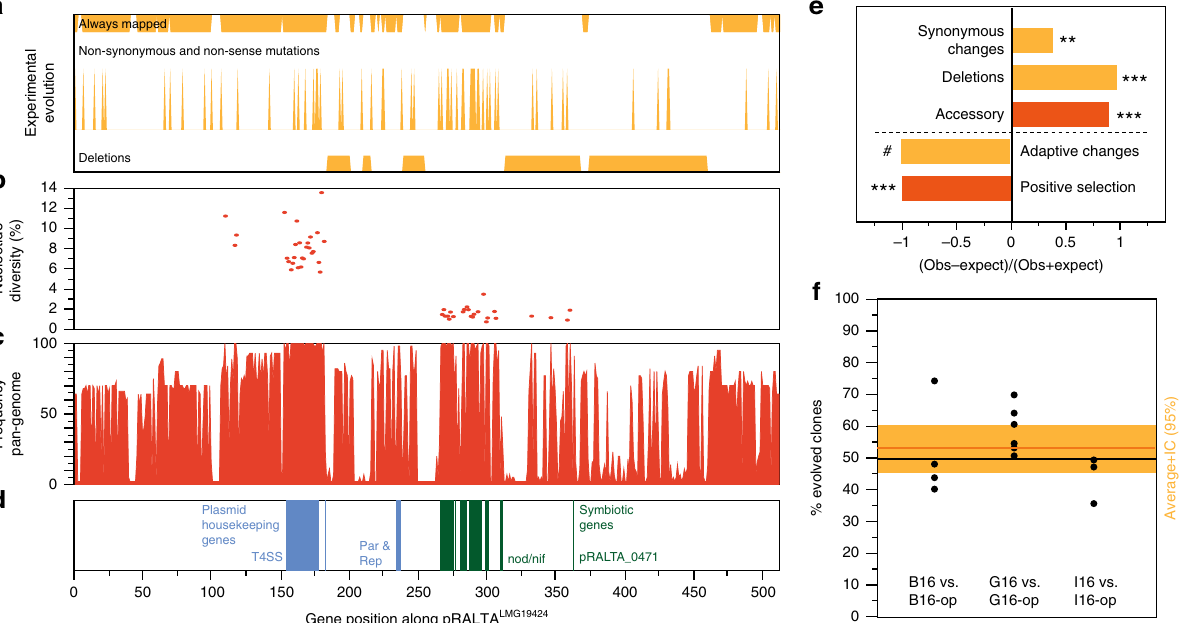
Fig. 3 Analysis of the symbiotic plasmid of C. taiwanensis LMG19424. a Deletions, non-synonymous and non-sense mutations, and regions of the plasmid that could always be mapped to identify mutations in the experiment. b Nucleotide diversity of natural C. taiwanensis core genes: symbiotic genes accumulated much less diversity than the other genes. c Frequency of each gene in the 44 C. taiwanensis (positional orthologs). d Symbiotic and plasmid housekeeping genes. e Observed over expected values for a number of traits in the plasmid natural (red) or experimental (orange) evolution (Supplementary Tables 1, 4, and Data 5). **/***signi fi cantly different from 1 ( P < 0.01/0.001, Fisher ’ s exact tests for all but the test for “ Synonymous changes ” which was made by permutations, see Methods and Supplementary Table 5). # We could not fi nd a single adaptive mutation in the plasmid in our previous works neither in the experiments in panel ( f ). f Impact of pRalta mutations on the in planta fi tness of evolved clones. M. pudica plantlets were co-inoculated with pairs of strains at a 1:1 ratio and nodules were harvested at 21 dpi for bacteria counting. Each pair consisted of an evolved clone (B16, G16 or I16) and the same clone with the evolved pRalta replaced by the original one (B16-op, G16-op or I16-op). Each dot represents an independent experiment. The orange horizontal bar represents the average and the large orange rectangle the 95% interval of con fi dence of the average ( t Student). This interval includes the value 50% indicating that the two types of clones are not signi fi cantly different in terms of fi